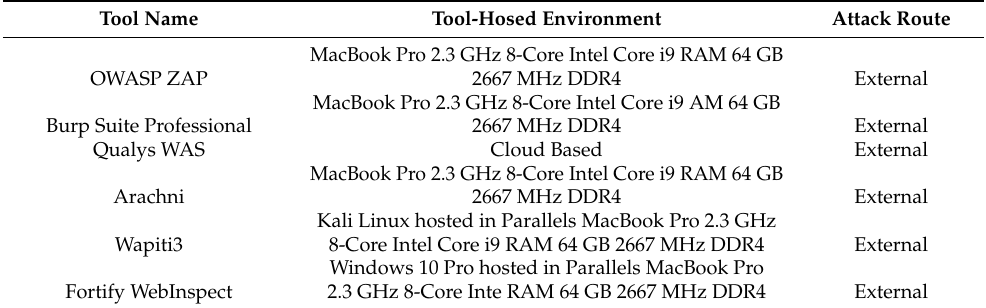
Table 3. Evaluated tools profile.